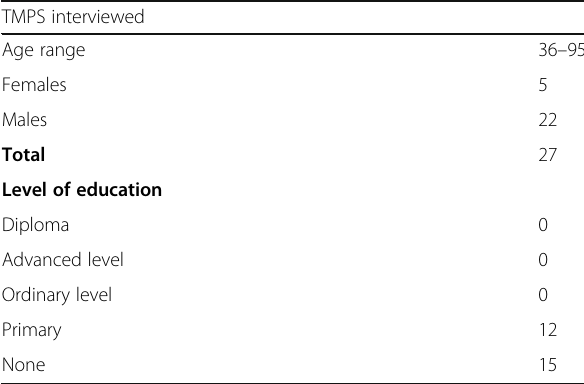
Table 1 Socio demographic characteristics of the